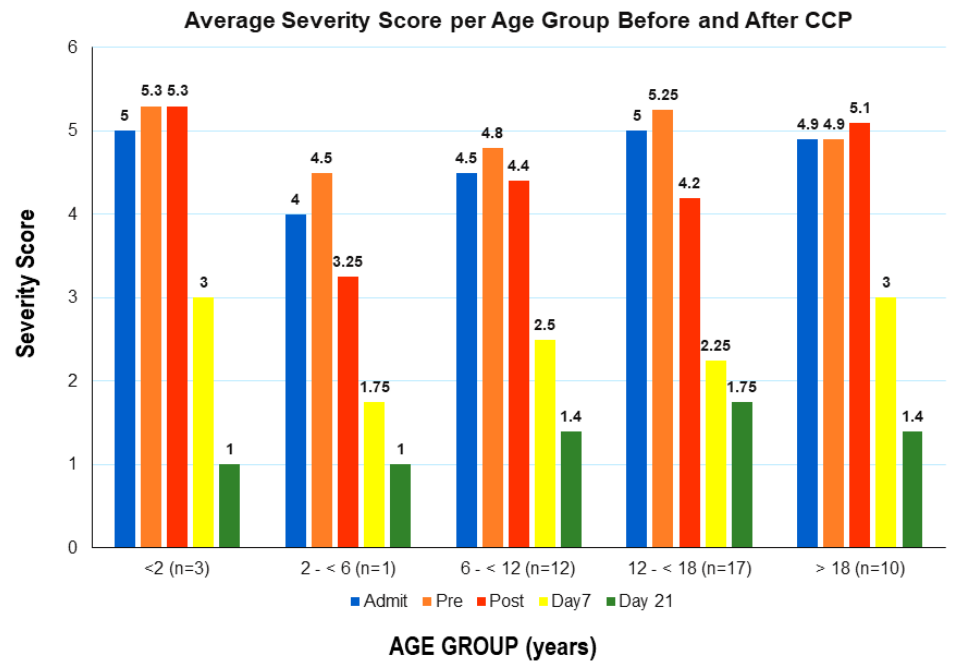
Figure 4. Severity score for all age groups remained similar or declined at 24 h post-CCP infusion supporting the safety of CCP. By day 7 score had substantially improved (3—no oxygen). Most patients had been discharged to home (1—home) by day 21. The numbers in each group were too small to allow for statistical